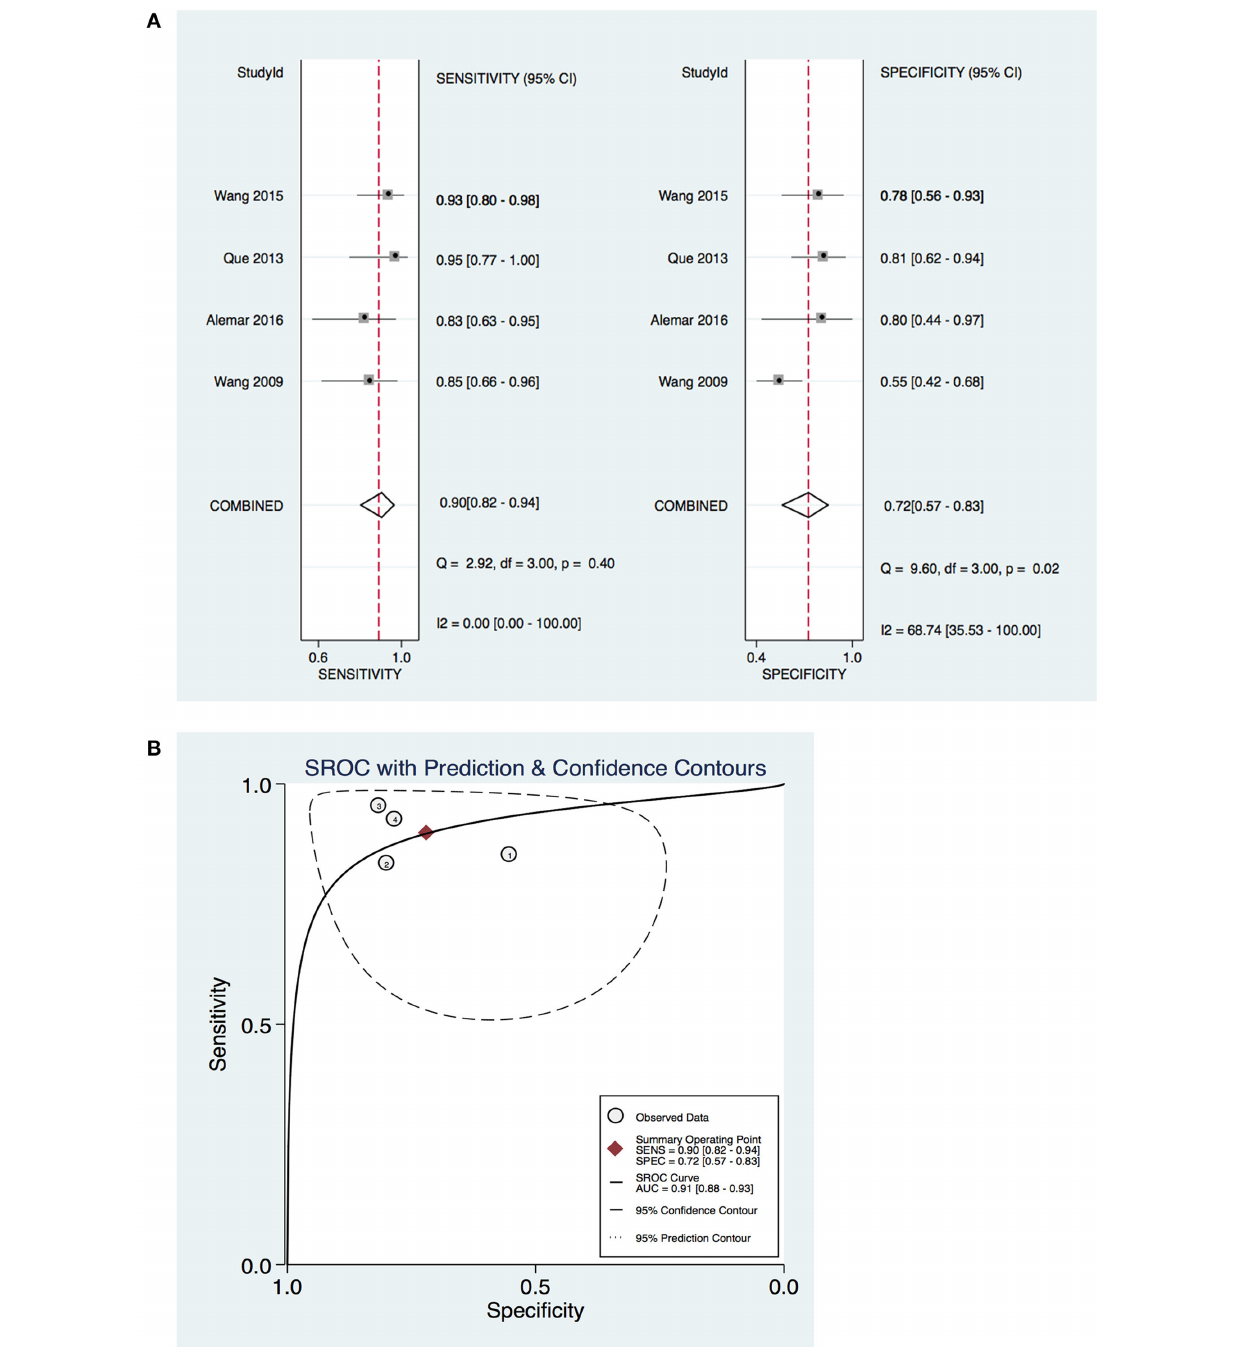
oncogenic function in pancreatic cancer (Park et al., 2009;